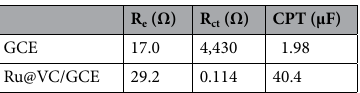
Table 1. Parameters calculated from EIS.